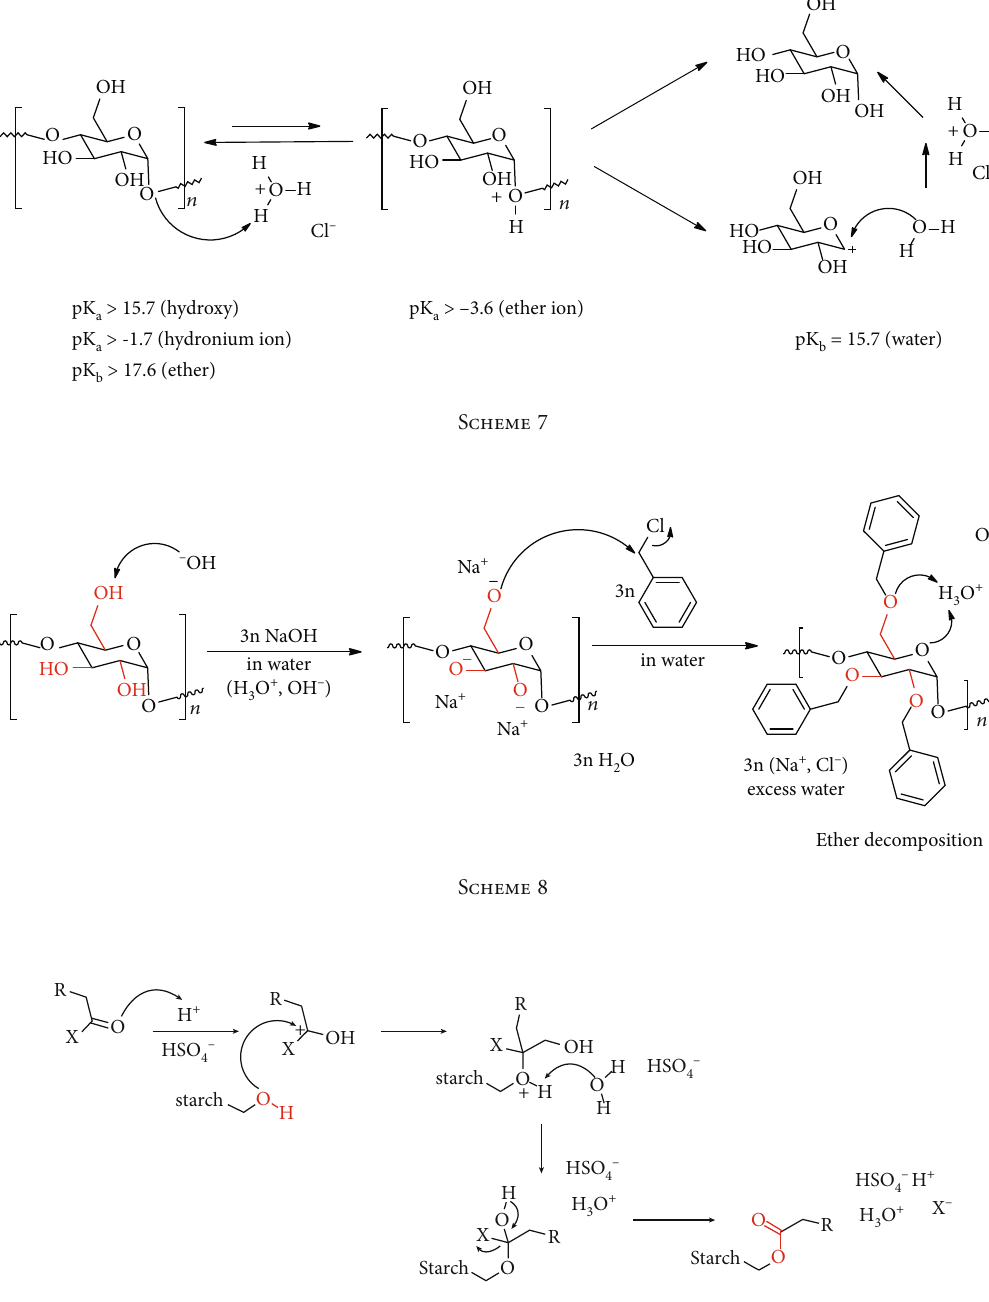
Scheme 9: Fischer ’ s esteri fi